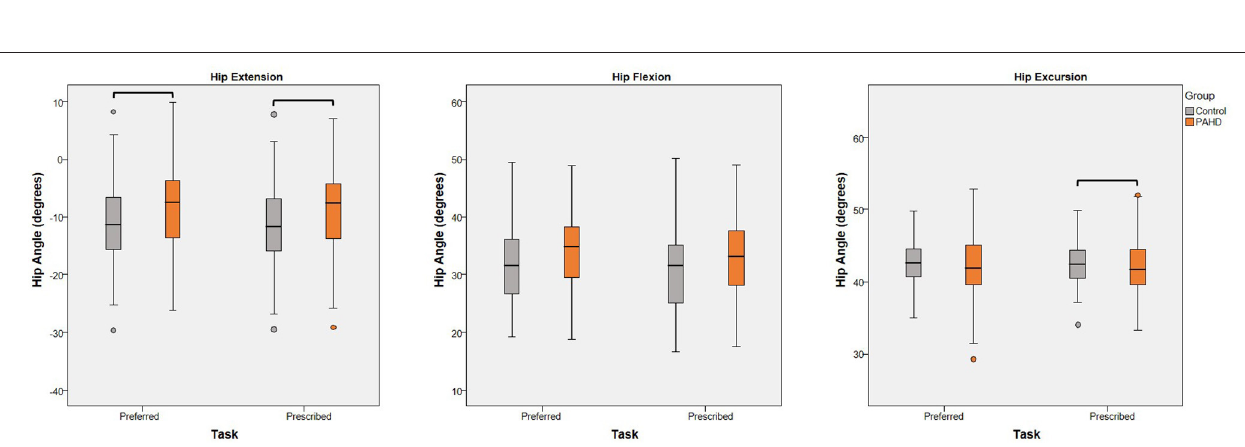
FIGURE 2 | Effect of Sex: Box plots (and outliers) for each dependent variable (peak hip extension, peak hip flexion, and hip excursion) for females and males walking at each of three speed tasks (preferred, prescribed, and fast). At each walking speed, males walked with less hip flexion and less hip excursion than females. No differences in peak hip extension were noted. Hip flexion is represented as positive. Bars indicate significant differences.